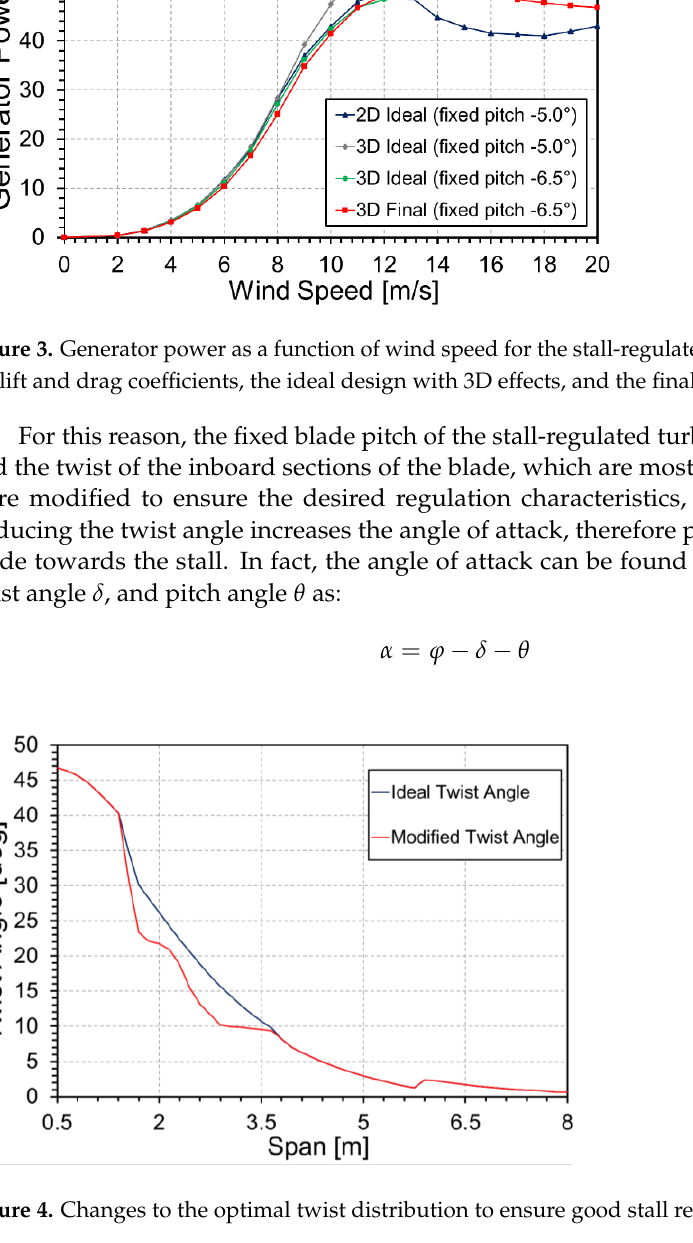
Figure 4. Changes to the optimal twist distribution to ensure good stall regulation.